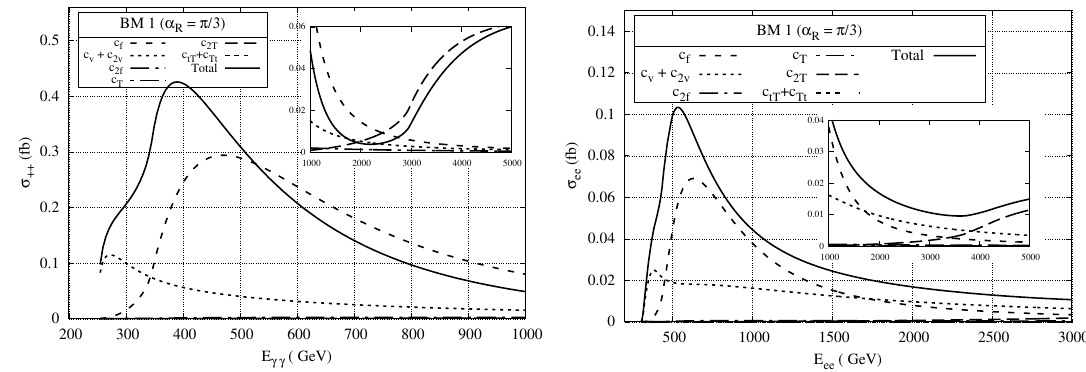
Figure 16 . Cross-sections for the individual contributions as given in tables 1 and 6 for γγ → hh same photon helicities (left panel) and e + e − → hh (right panel) in the presence of a Singlet Vector Like Top-quark (as given in section 5.1).